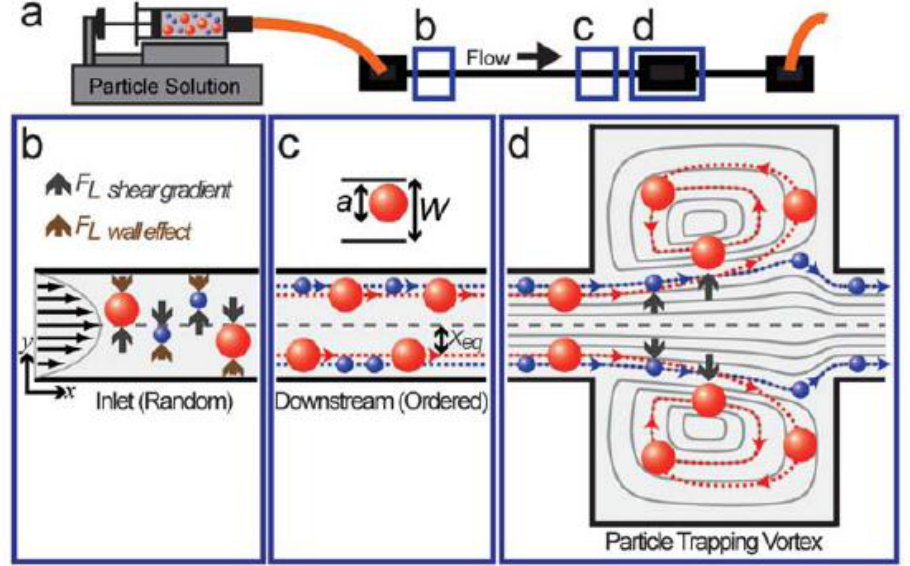
Figure 3. Particle entry mechanism in laminar microvortices. ( a ) For a polydisperse particle solution injected into a device with a straight high aspect ratio channel leading into an expansion-contraction chamber we expect size-dependent entry into the laminar vortices created; ( b , c ) Particles are subjected to a shear gradient lift force, which directs particles toward the channel wall, and a wall effect lift force, directed toward the channel center, which leads to entrainment of particles at dynamic equilibrium positions, X eq ; ( d ) As focused particles enter the vortex chamber, the lift forces are decoupled due to the absence of a nearby wall, resulting in a dominate shear gradient lift force. Larger particles (red) experience larger lift forces and are able to migrate across fluid streamlines into the vortices while smaller particles (blue) follow fluid streamlines and flow out of the system [103] with permission of The Royal Society of